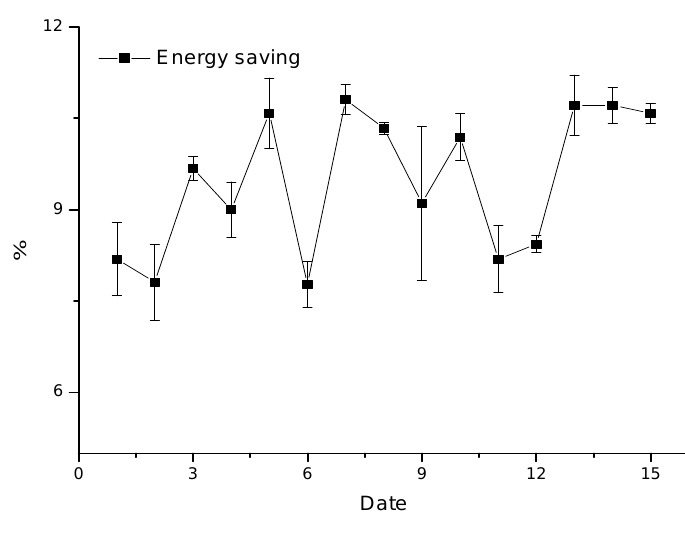
Figure 14. Deviations from the